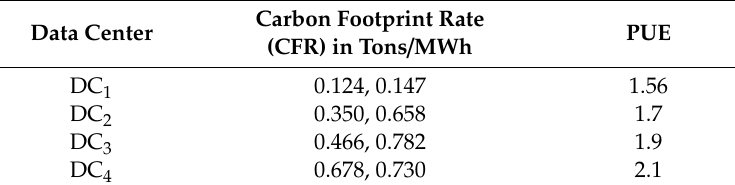
Table 4. Datacenter features [25].